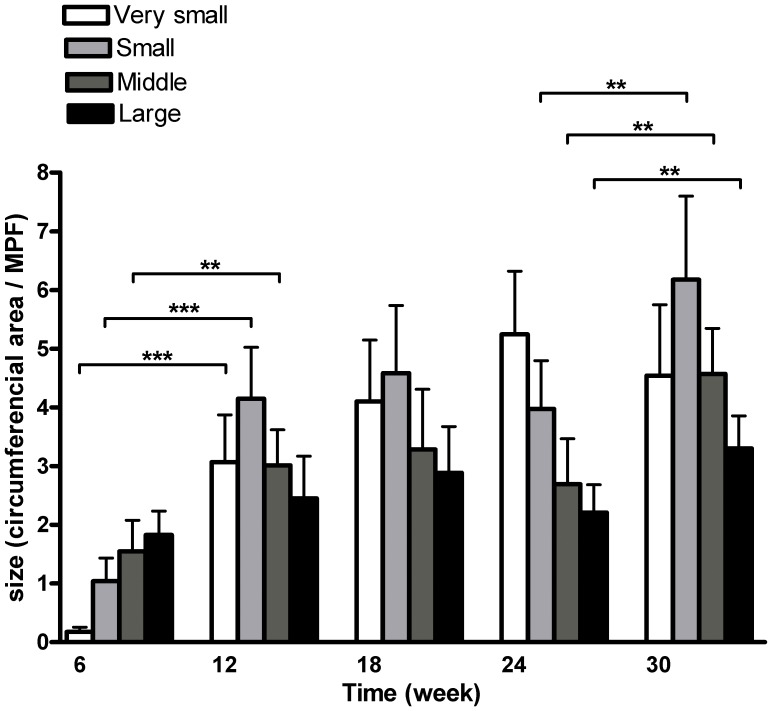
Quantification of surface area of all lymph vessels counted in proteinuric kidneys over time.All double positive lymph vessels have been divided into four categories based on their size. At 6 weeks, small, middle-size and large lymph vessels were present in close association with larger blood vessels, however there were almost no very small LV, indicating no lymph vessel formation. Over time, the number of very small LV significantly increased up to week 24. Besides, the number of small, middle-size and large LV increased between week 6–12 and/or between weeks 24–30, implying growth and enlargement of LV in these time frames. (**p<0.01; ***p<0.001).